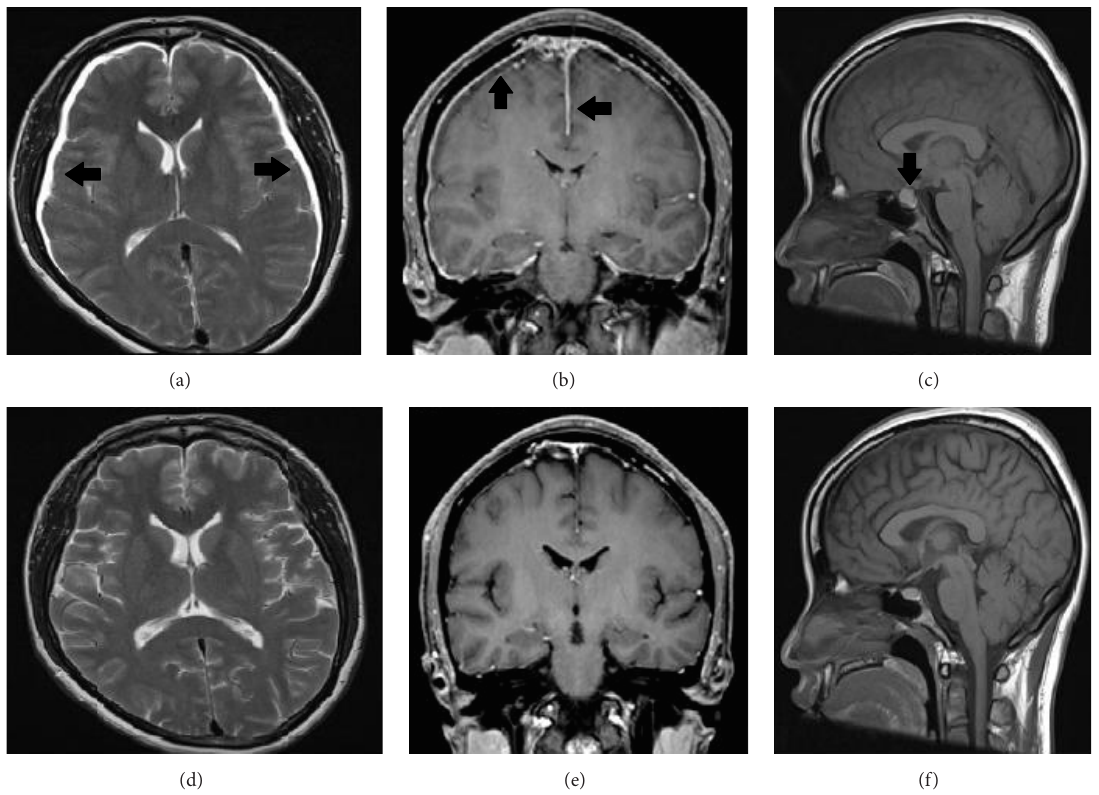
Figure 2: (a) Axial T2 weighted sequence demonstrates bilateral CSF-intensity subdural hygromas (arrows). (b) Coronal T1 weighted gadolinium enhanced sequence demonstrates pachymeningeal thickening and enhancement (arrows). (c) Sagittal T1 weighted sequence demonstrates pituitary gland enlargement. (d)–(f) Posttreatment MRI examination demonstrates complete radiological resolution.